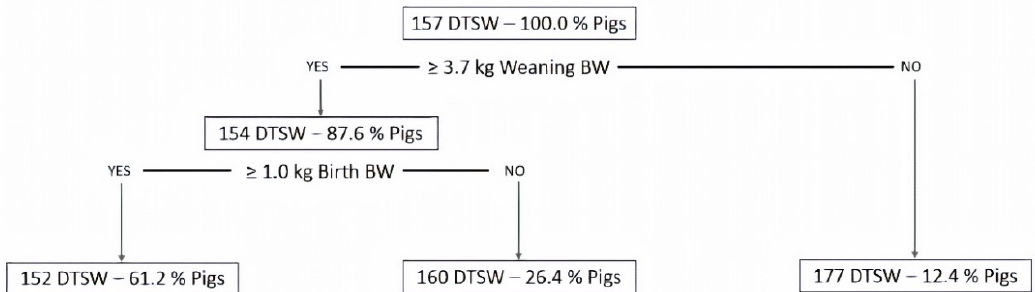
Figure 1. Regression tree analysis used to estimate cut-off values for birth and weaning BW to identify slow growing pigs within a batch. Model included the days to target slaughter weight (DTSW; i.e., 110 kg of BW) as the outcome variable, and birth body weight and weaning body weight as predictor variables. Pigs with body weight lower than 3.7 kg of BW at weaning (i.e., 28 days of age) would be considered slow growing pigs. Regression tree analysis was performed using the rpart package [26] of R v3.5.2 [27].